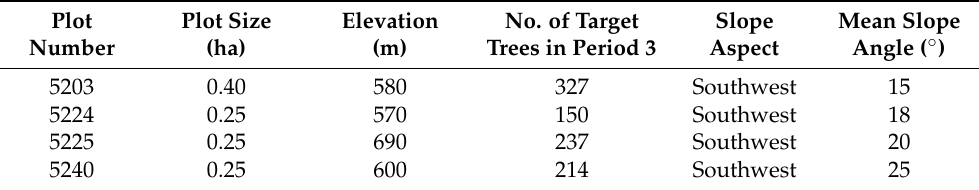
Table 1. Location and features of the investigated preserved plots of